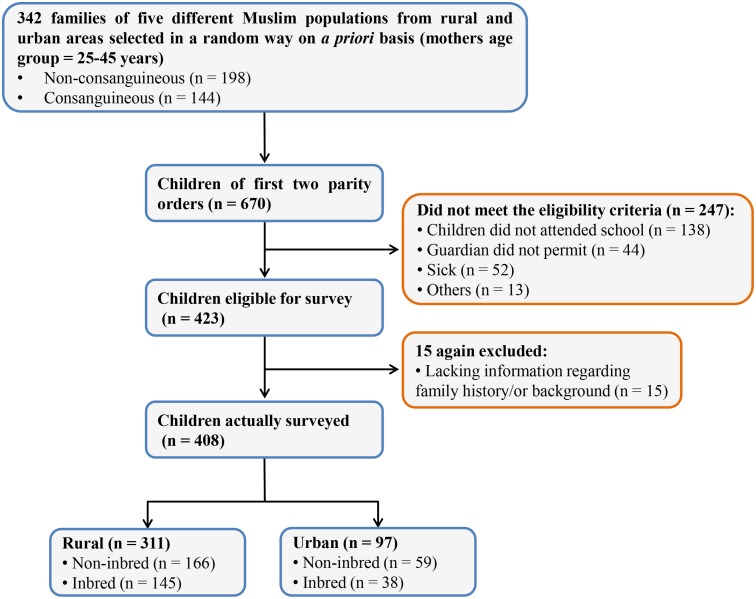
Study design.Flowchart depicting the steps involved in the recruitment process.